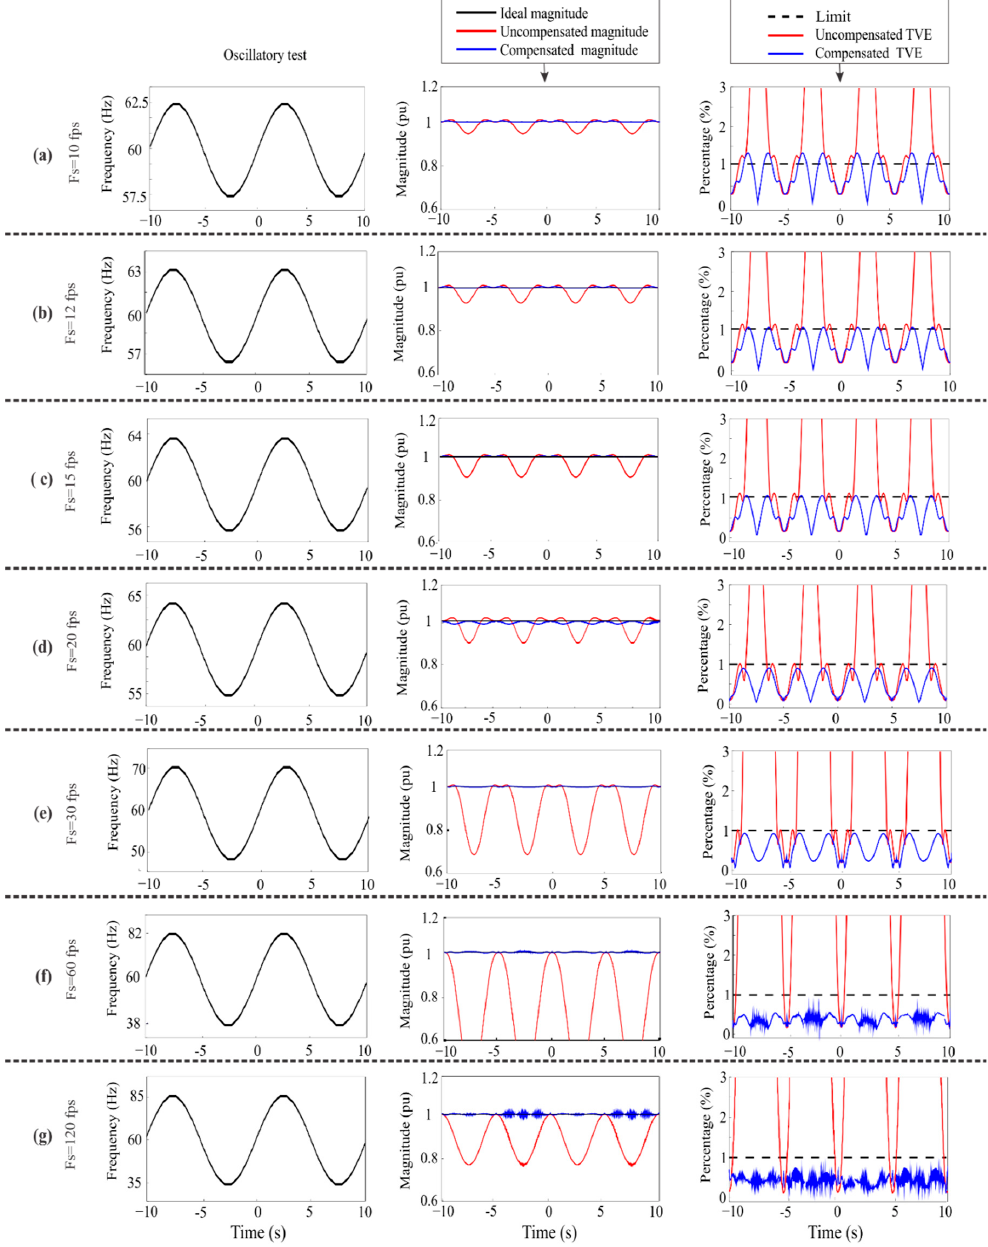
Figure 7. Magnitude and TVE results for: ( a ) 10 fps, ( b ) 12 fps, ( c ) 15 fps, ( d ) 20 fps, ( e ) 30 fps, ( f ) 60 fps and ( g ) 120 fps.